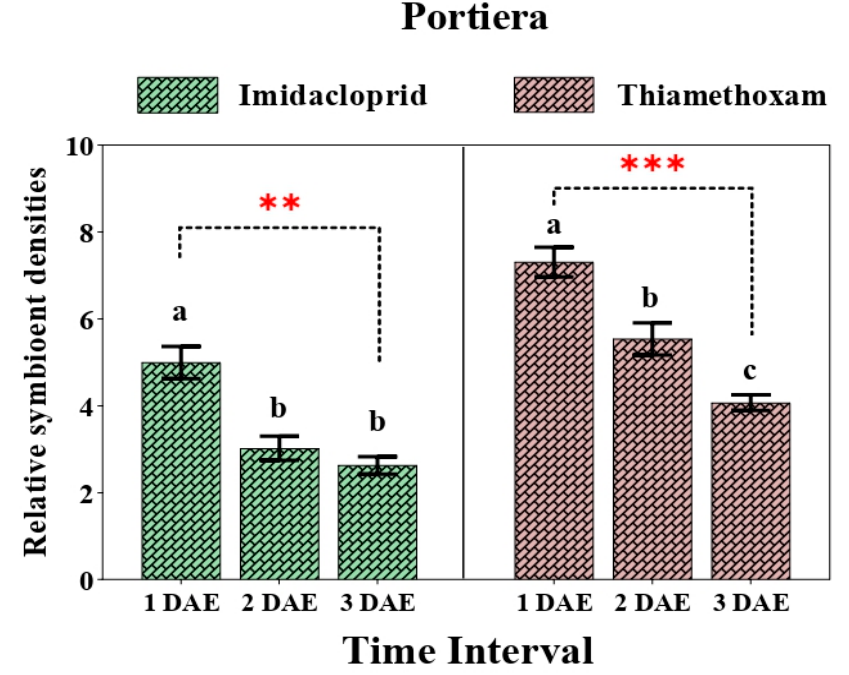
Figure 3. Relative density of C. portiera in whiteflies after exposure to sublethal doses of imidacloprid 17.80 SL and thiamethoxam 25 WG at various durations (1 DAE, 2 DAE, and 3 DAE). Bars represent the standard error of the mean (SEM), and the different letters indicate statistically significant differences between the treatments. p ≤ 0.01 is indicated by **, and p ≤ 0.001 is indicated by ***. DAE, days after exposure.